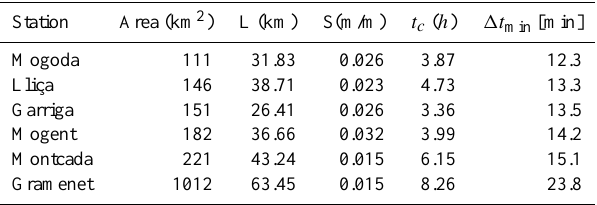
Table 4. Basin area (km 2 ), length of the main watercourse (km), slope between maximum and minimum elevation (m/m), time of concentration by the Kirpich formula ( h ) and required minimum time resolution of rainfall in Mediterranean regions (min) of Bes`os basin stations.